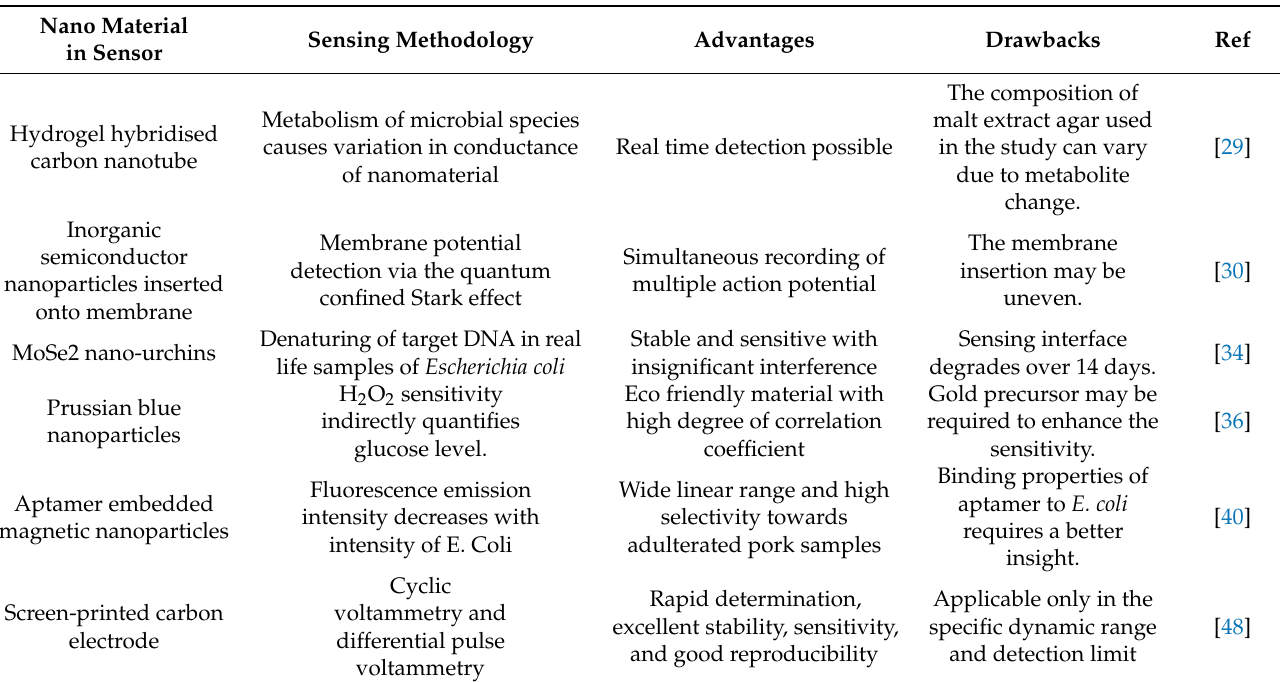
Table 3. Comparison of analytical performance of nano-based sensors in biological detection and the food